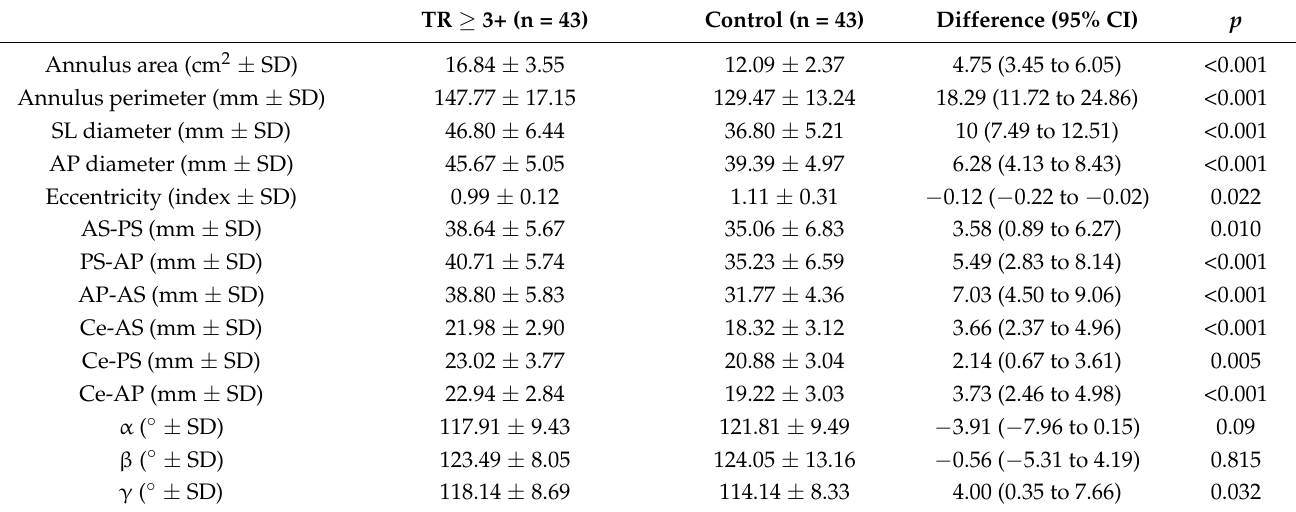
Table 3. Tricuspid valve measurements and differences between